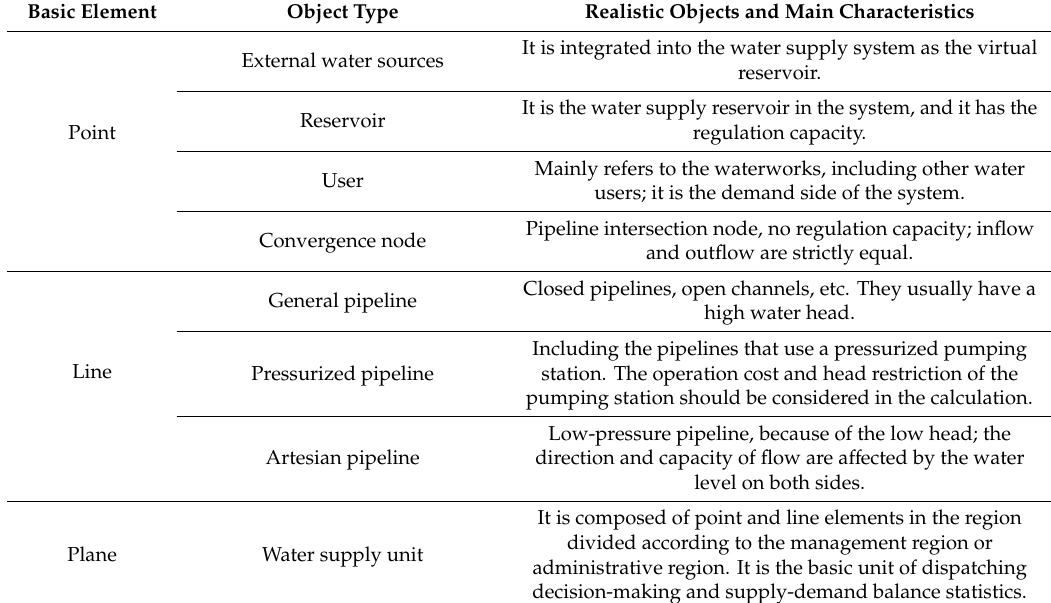
Table 1. Basic graphic elements and their characteristics of the generalization chart of the water supply